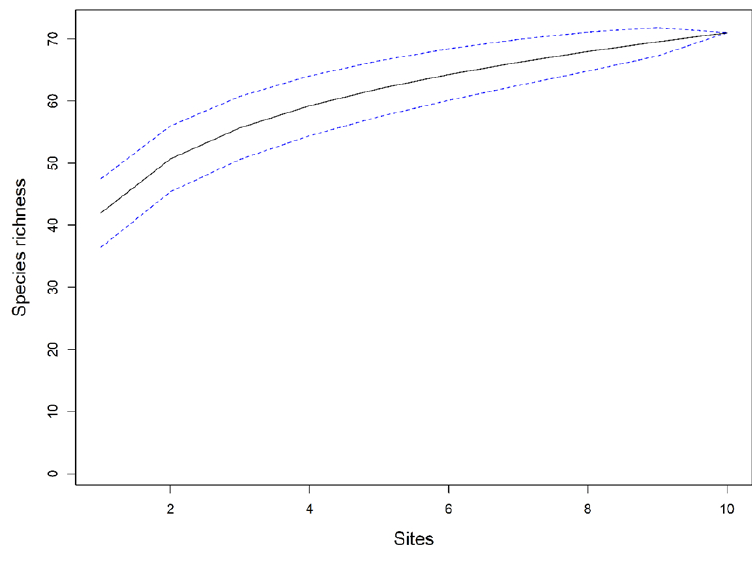
Figure 2. Diatom’s species accumulation curve constructed by using the rarefaction method (black line with 95% confidence